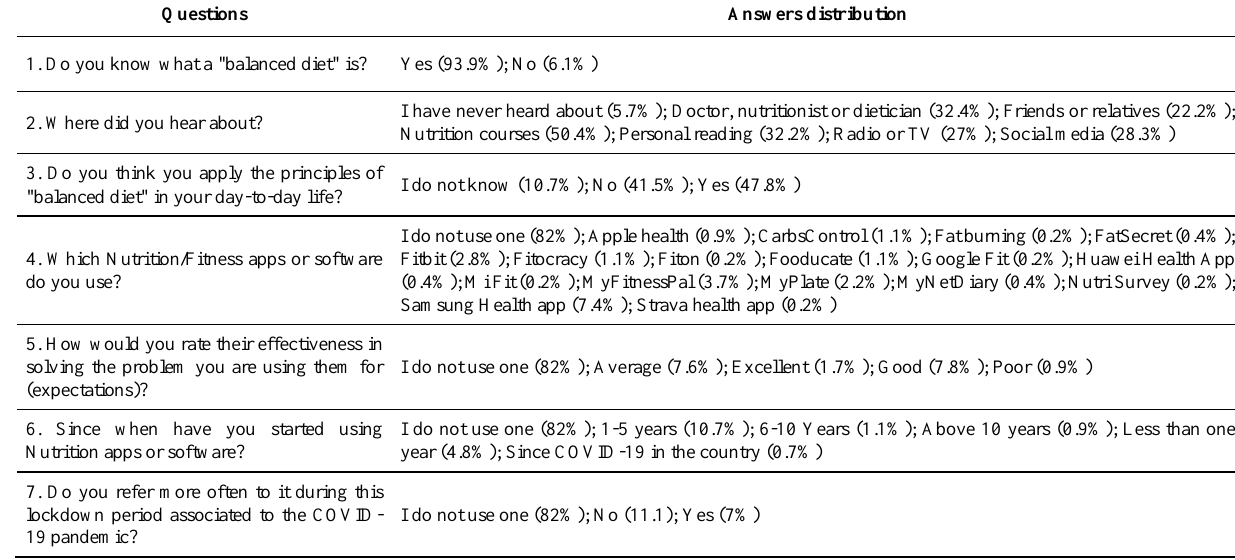
Table 2. Level of nutrition related apps/software usage and reasons behind